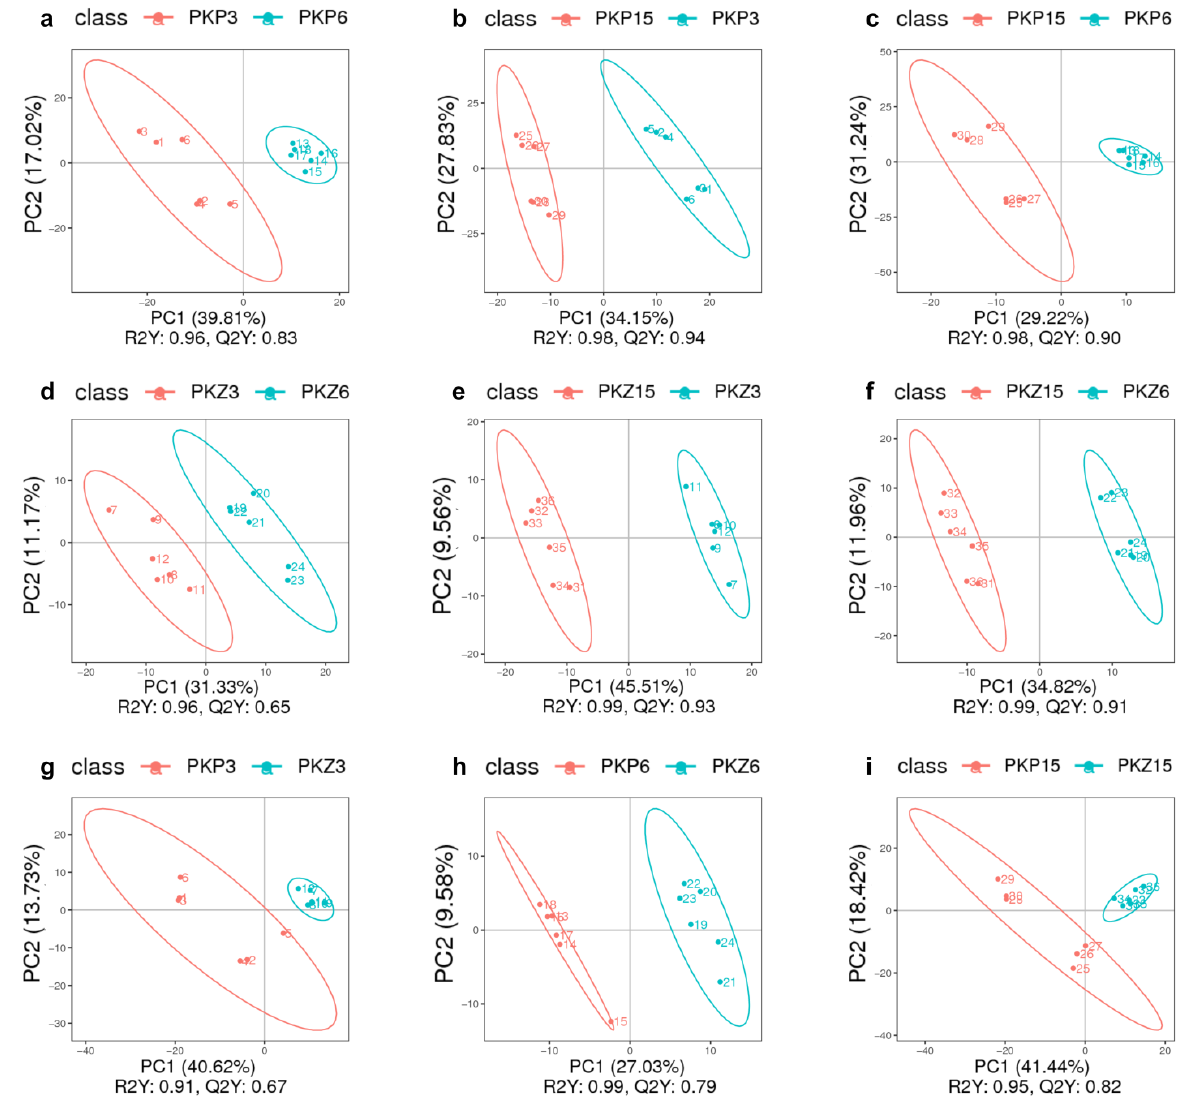
Figure 4. PLS-DA score plot of positive and negative ion modes for each comparison group (negative ion mode). PKP3-PKZ15 is the same as Table 1. ( a – i ) is the same as Figure 3. Table 2. Evaluation parameters of the PLS-DA model. Sample Comparison